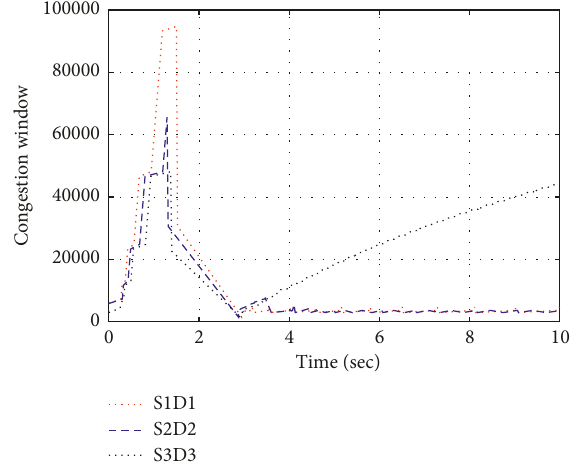
Figure 1: TCP congestion window obtained in simulation of